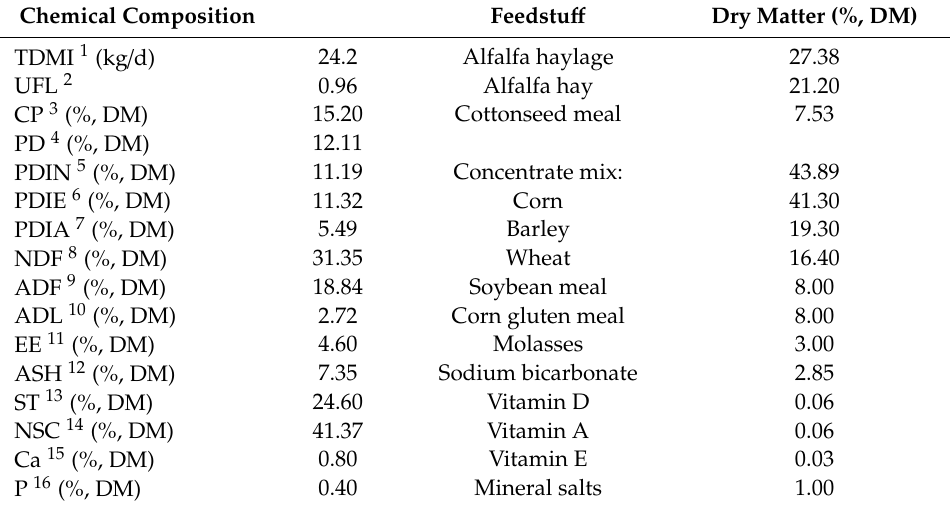
Table 1. Chemical composition of the Total Mixed Ration (TMR) and feedstu ff with % dry matter (DM) in lactation